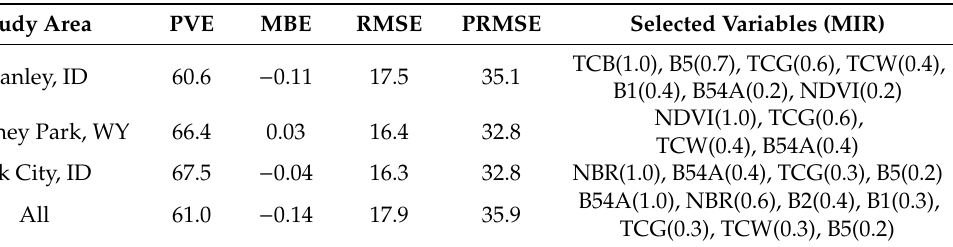
Table 4. Model performance statistics and selected variables and their importance for cross-validated Random Forest models predicting percent mortality from Landsat variables. PVE = percent variance explained; MBE = mean bias error; RMSE = root mean squared error, PRMSE = percent root mean squared error; MIR = model improvement ratio, where values of zero indicate less important and values of one indicate most important; B1 = band 1; B5 = band 5; NBR = normalized burn ratio; NDVI = normalized di ff erence vegetation index; TCB = tasseled-cap brightness; TCG = tasseled-cap greenness; TCW = tasseled-cap wetness; B54A = band 5 / band 4 anomaly from undisturbed mean.